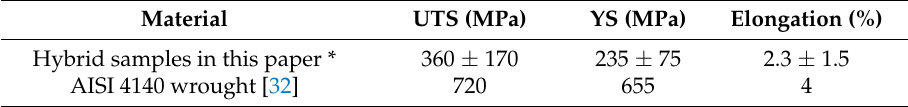
Table 1. Tensile properties comparison between hybrid samples and the wrought counterpart. Material Hybrid samples in this paper *